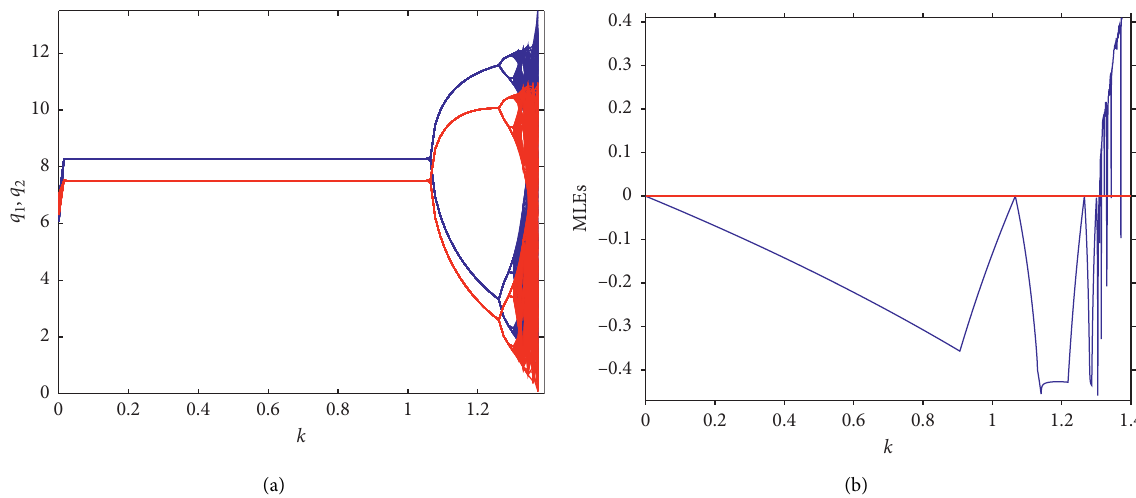
Figure 3: Bifurcation diagram and MLEs for game (12) with respect to control parameter k at a � 6 , b � 0 . 3 , c